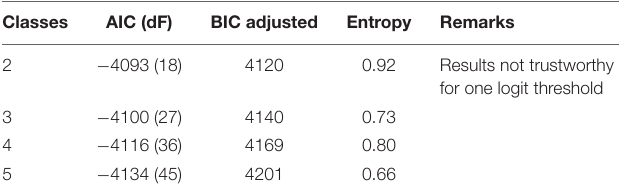
TABLE 2 | Modell fit-indices for a different amount of classes for the multigroup-latent class analysis, configural invariance testing for the four gender dimensions, N = 785.